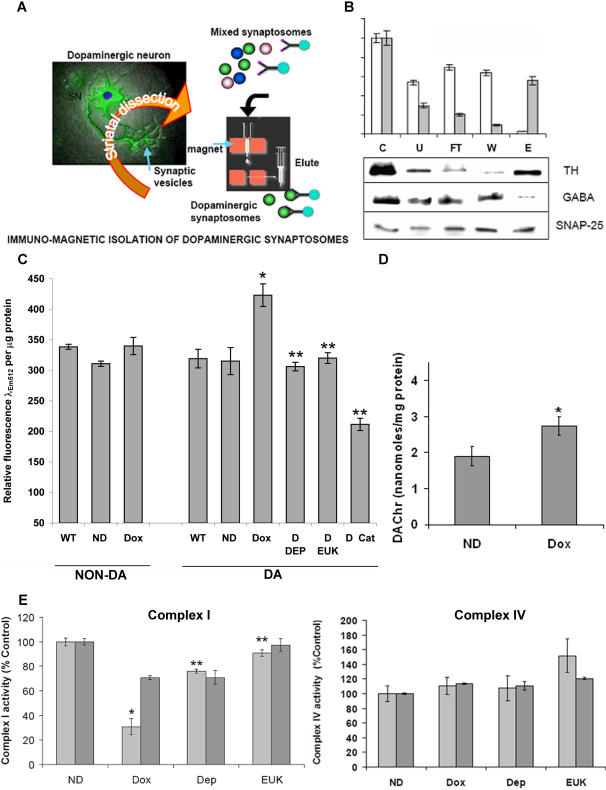
Effects of elevations of astrocytic MAO-B on H2O2 and dopaminochrome (DAChr) levels, and mitochondrial complex I versus IV activities in isolated ST dopaminergic versus non-dopaminergic synaptosomes. A. Schematic of novel immunomagnetic technique utilized to for isolate ST dopaminergic versus non-dopaminergic synaptosomes.Synaptosomes were prepared from freshly dissected striata and the dopaminergic population rapidly isolated via immunoprecipitation with anti-DAT antibody following by separation by a magnetic particle-conjugated secondary antibody running through a strong magnetic column. Elution of the DA synaptosomes was obtained via removal of the magnetic field. Flow-through contains striatal non-dopaminergic synaptosomes used as negative controls in subsequent biochemical experiments. B. Densitometric quantitation of western blot analyses of fractions from immunomagnetic isolation of ST synaptosomes probed with TH, GABA or SNAP-25 antibodies. Levels of Dopaminergic TH (grey bars) versus Non-dopaminergic GABA (white bars) synaptosomes were assessed using SNAP-25, a general synaptic protein, as a loading control. Control (C), unbound fraction (U), flow-through (FT), wash (W) and eluate (E). Representative blots are shown in the lower panel. C. Elevation in astrocytic MAO-B results in increased H2O2 within dopaminergic ST synaptosomes. H2O2 levels were estimated 3 hrs following tail vein injection of DCFDA into either wildtype littermates (WT), uninduced (ND) or dox-induced (Dox) transgenics, or induced transgenic animals co-treated with either deprenyl (D DEP), EUK189 (D EUK) or 1 mg/ml catalase (Dox Cat). DCF fluorescence was examined at an excitation wavelength of 488 nm and emission at 512 nm. Data is reported normalized to microgram synaptosomal protein. N = 3; *p<0.005 versus ND, ** = p<0.01 versus Dox. D. Elevation in astrocytic MAO-B results in increased ST DAChr levels. DAChr levels were estimated in ST samples from uninduced (ND) versus dox-induced (Dox) transgenic mice via HPLC. Values are presented as picomoles DAChr/mg protein.* p<0.02, n = 3. E. Elevation in astrocytic MAO-B results in decreased complex I but not complex IV activity in ST dopaminergic synaptosomes. Complex I and complex IV activities were measured in isolated ST dopaminergic versus non-dopaminergic synaptosomes from uninduced (ND), dox-induced (Dox) and induced transgenic animals co-treated with either deprenyl (Dep) or EUK-189 (EUK). N = 3–5 animals per group and a total of 3 separate experiments, values are expressed as mean±SD; * p<0.01 compared to ND, ** p>0.05 compared to ND. CI activity was calculated to be 4.0 versus 3.3 µM NADH/min/mg protein in ND striatal dopaminergic and non-dopaminergic synaptosomes, respectively. CIV activity was calculated to be 139 versus 109 µM ferrocytochrome c/minute/mg protein in ND striatal dopaminergic and non-dopaminergic synaptosomes, respectively. Activities of WT DA striatal synaptosomes was calculated to be 4.4 µM NADH/min/mg protein (CI) and 130 µM ferrocytochrome c/minute/mg protein (CIV); dox feeding of the WT animals did not alter the activities. Note: addition of doxycycline has been reported to interfere with mitochondrial protein translation including CI thereby affecting enzyme activity [62], however in addition to lack of effect on CI activity in WT animals +/− dox, we also find no change in CI subunit protein levels in WT mice as a consequence of dox treatment as assessed via immunoprecipitation/gel electrophoretic analyses (data not shown).